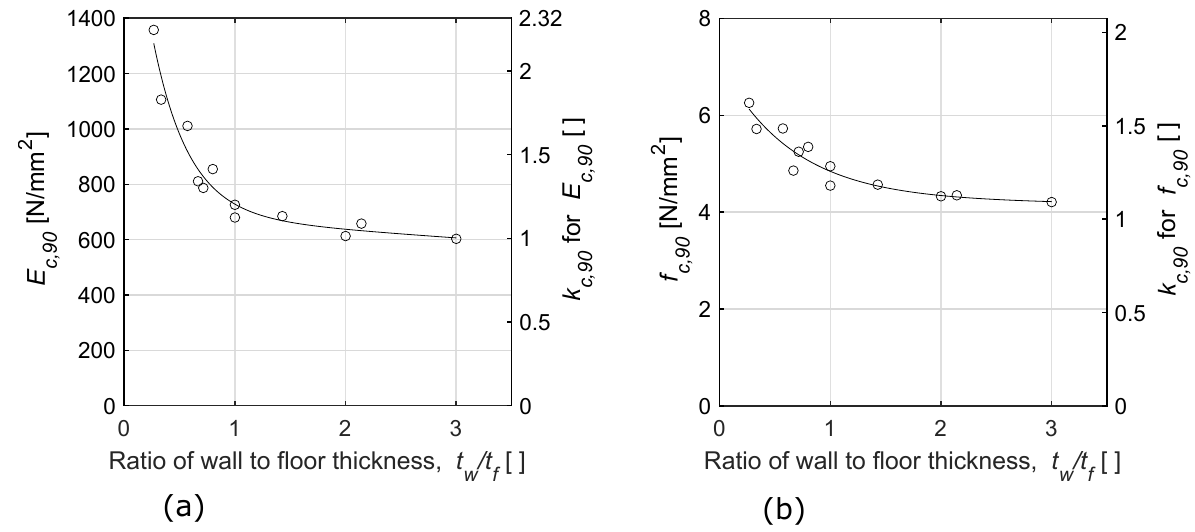
Figure 13. ( a ) E c ,90 and k c ,90 for E c ,90 and ( b ) f c ,90 and k c ,90 for f c ,90 as a function of wall-to-floor thickness, t w / t f . There is a clear decreasing relationship for all parameters with increasing t w / t f from 0.27 to about 1.50. The parameter study gave a variation of E c ,90 between 603 and 1358 N/mm 2 while the variation of f c ,90 was between 4.21 and 6.25 N/mm 2 . The highest E c ,90 and f c ,90 were found for a t w / t f equal to 0.27 ( W80-F300 ), with the thinnest wall and the thickest floor. The figures also show the variation of the parameters for the same t w / t f . For instance, for a ratio of 1, illustrated by t f = t w = 100 mm and t f = t w = 300 mm, the corresponding f c ,90 are 4.95 N/mm 2 and 4.55 N/mm 2 , which gives k c ,90 values of 1.28 to 1.18. It should be noted that the k c ,90 values are calculated for the reference stiffness and strength of a 140 mm floor element.